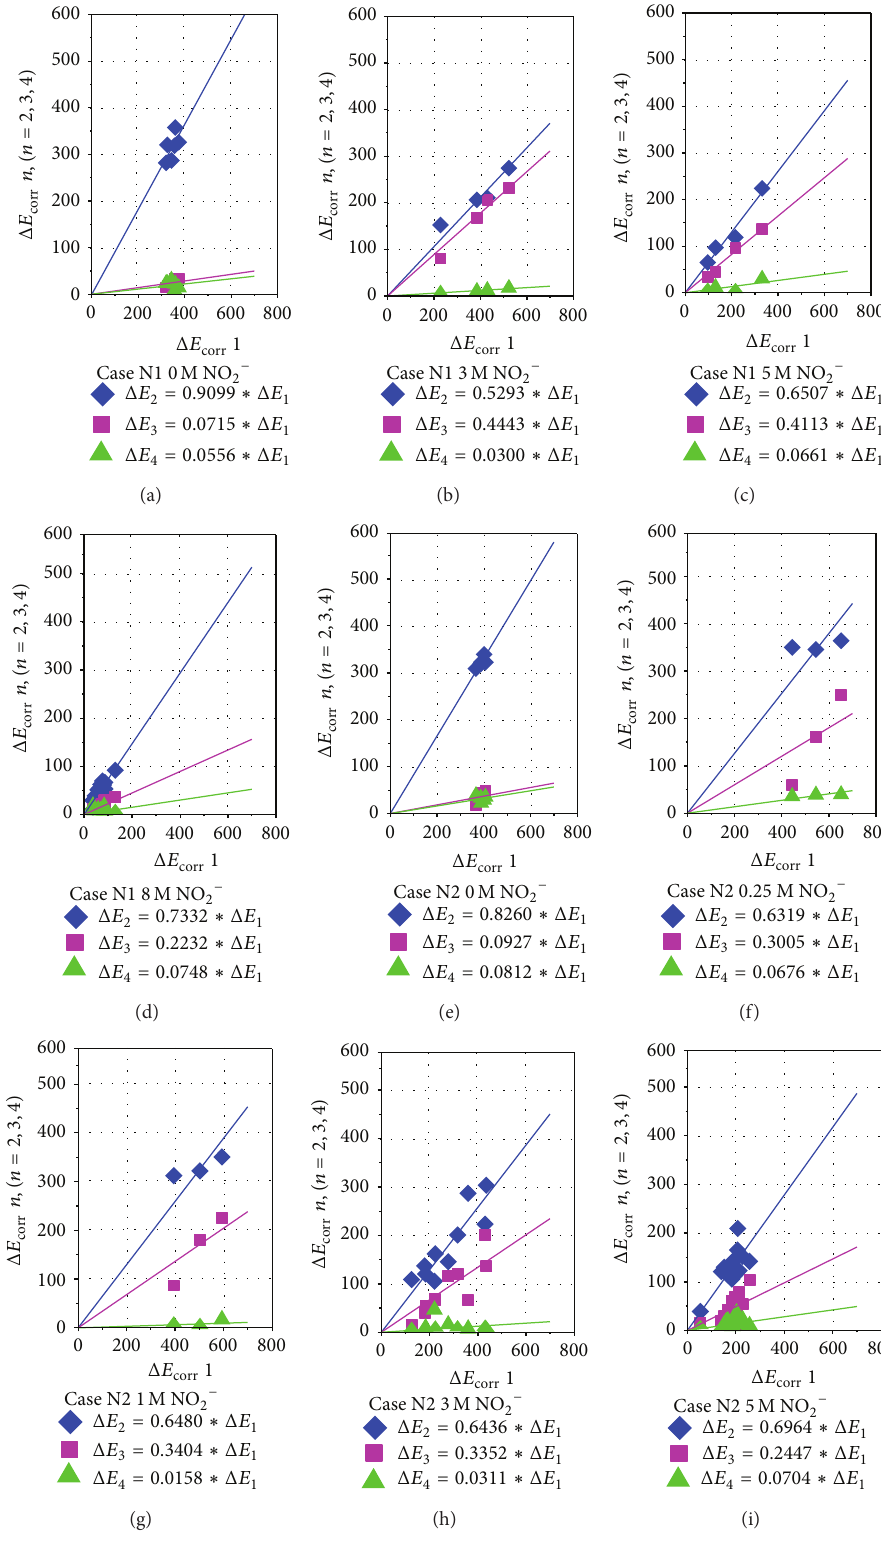
𝑛 ( 𝑛 = 2, 3, 4 ) for (a) Case N1, 0mol/L NO 2− , (b) Case N1, 3 mol/L NO 2− , (c) Case N1, Figure 7: Relationships between Δ𝐸 1 and Δ𝐸 corr corr 5 mol/L NO 2− , (d) Case N1, 8mol/L NO 2− , (e) Case N2, 0 mol/L NO 2− , (f) Case N2, 0.25 mol/L NO 2− , (g) Case N2, 1mol/L NO 2− , (h) Case N2, 3 mol/L NO 2− , and (i) Case N2, 5 mol/L NO 2−